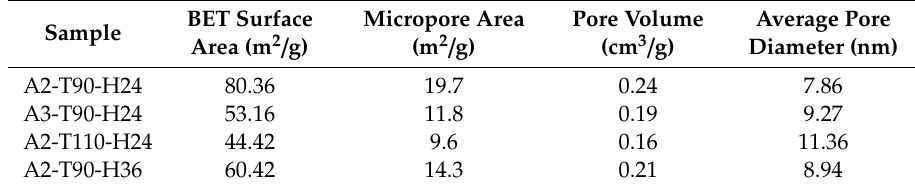
Table 3. Pore characteristics of self-supporting zeolite